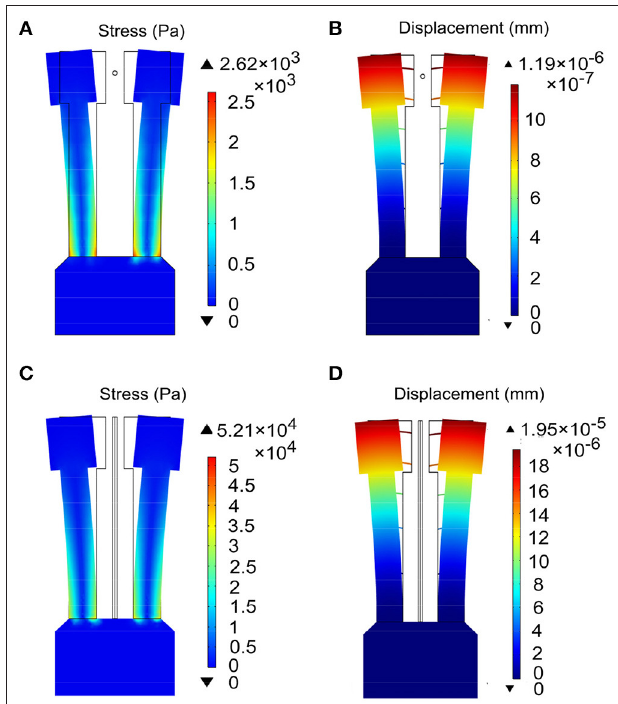
FIGURE 7 | The stimulated stress and displacement for the custom QTF in different QEPAS sensor systems. (A) QTF stress for traditional PP-QEPAS sensor. (B) QTF displacement for traditional PP-QEPAS sensor. (C) QTF stress for IP-QEPAS sensor. (D) QTF displacement for IP-QEPAS sensor. Reproduced from [ 90], with the permission of AIP